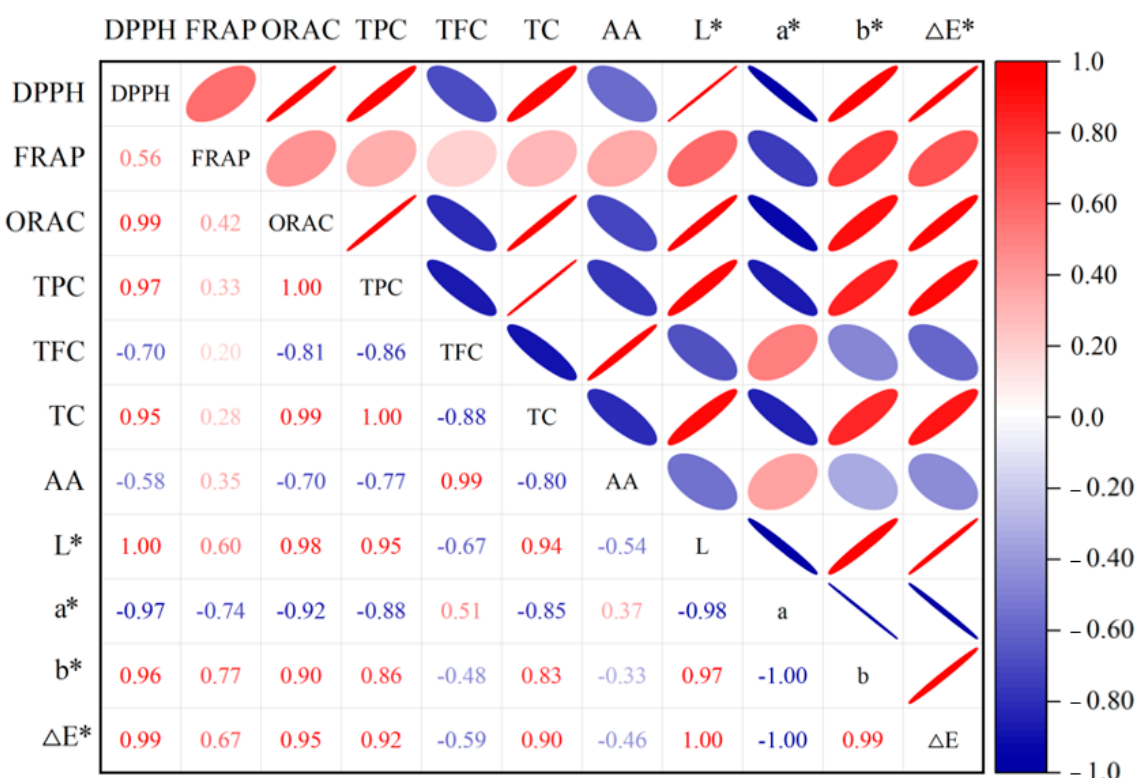
Figure 5. Correlation between the color attributes, antioxidants and antioxidant capacity of orange juice.